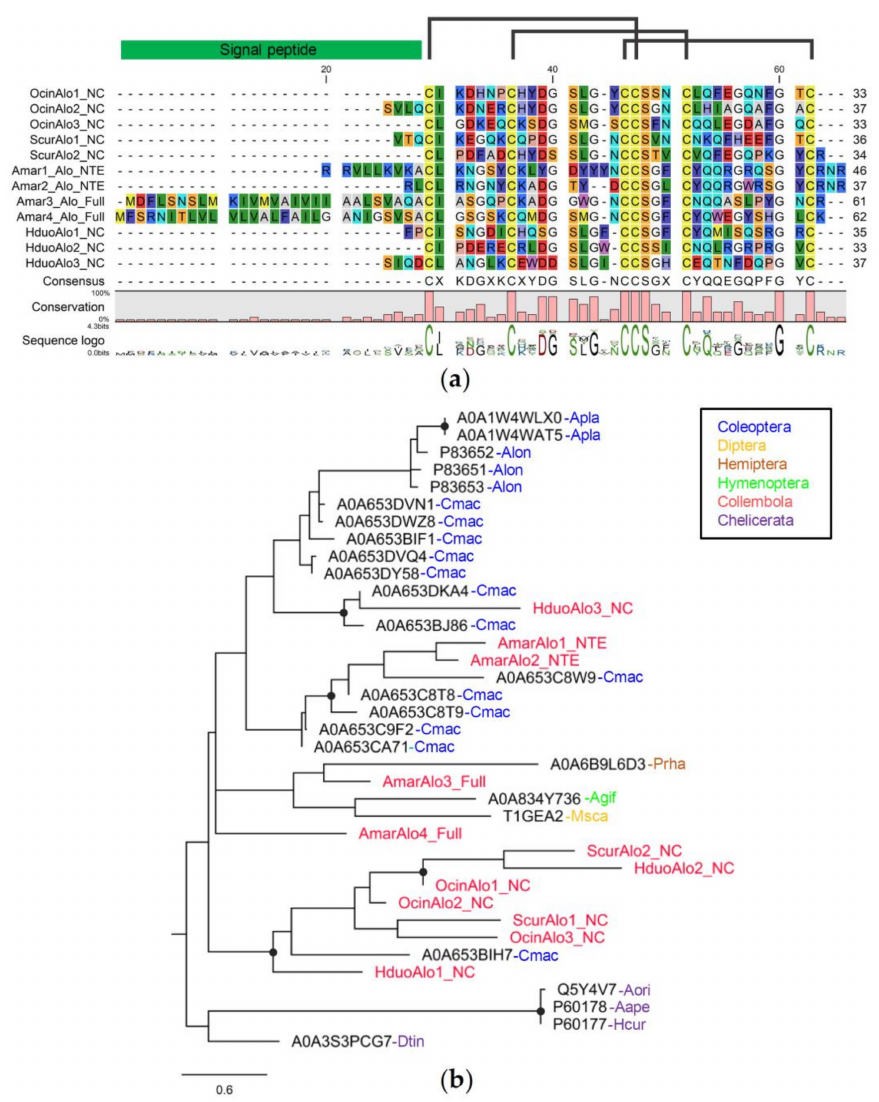
Figure 4. Sequence alignment and phylogenetic relationships of collembola Alo peptides: ( a ) protein alignment showing disulfide bridges between six conserved cysteine residues; ( b ) Phylogenetic tree of arthropod Alo peptides. Branch supports (aLRT) higher than 0.9 were